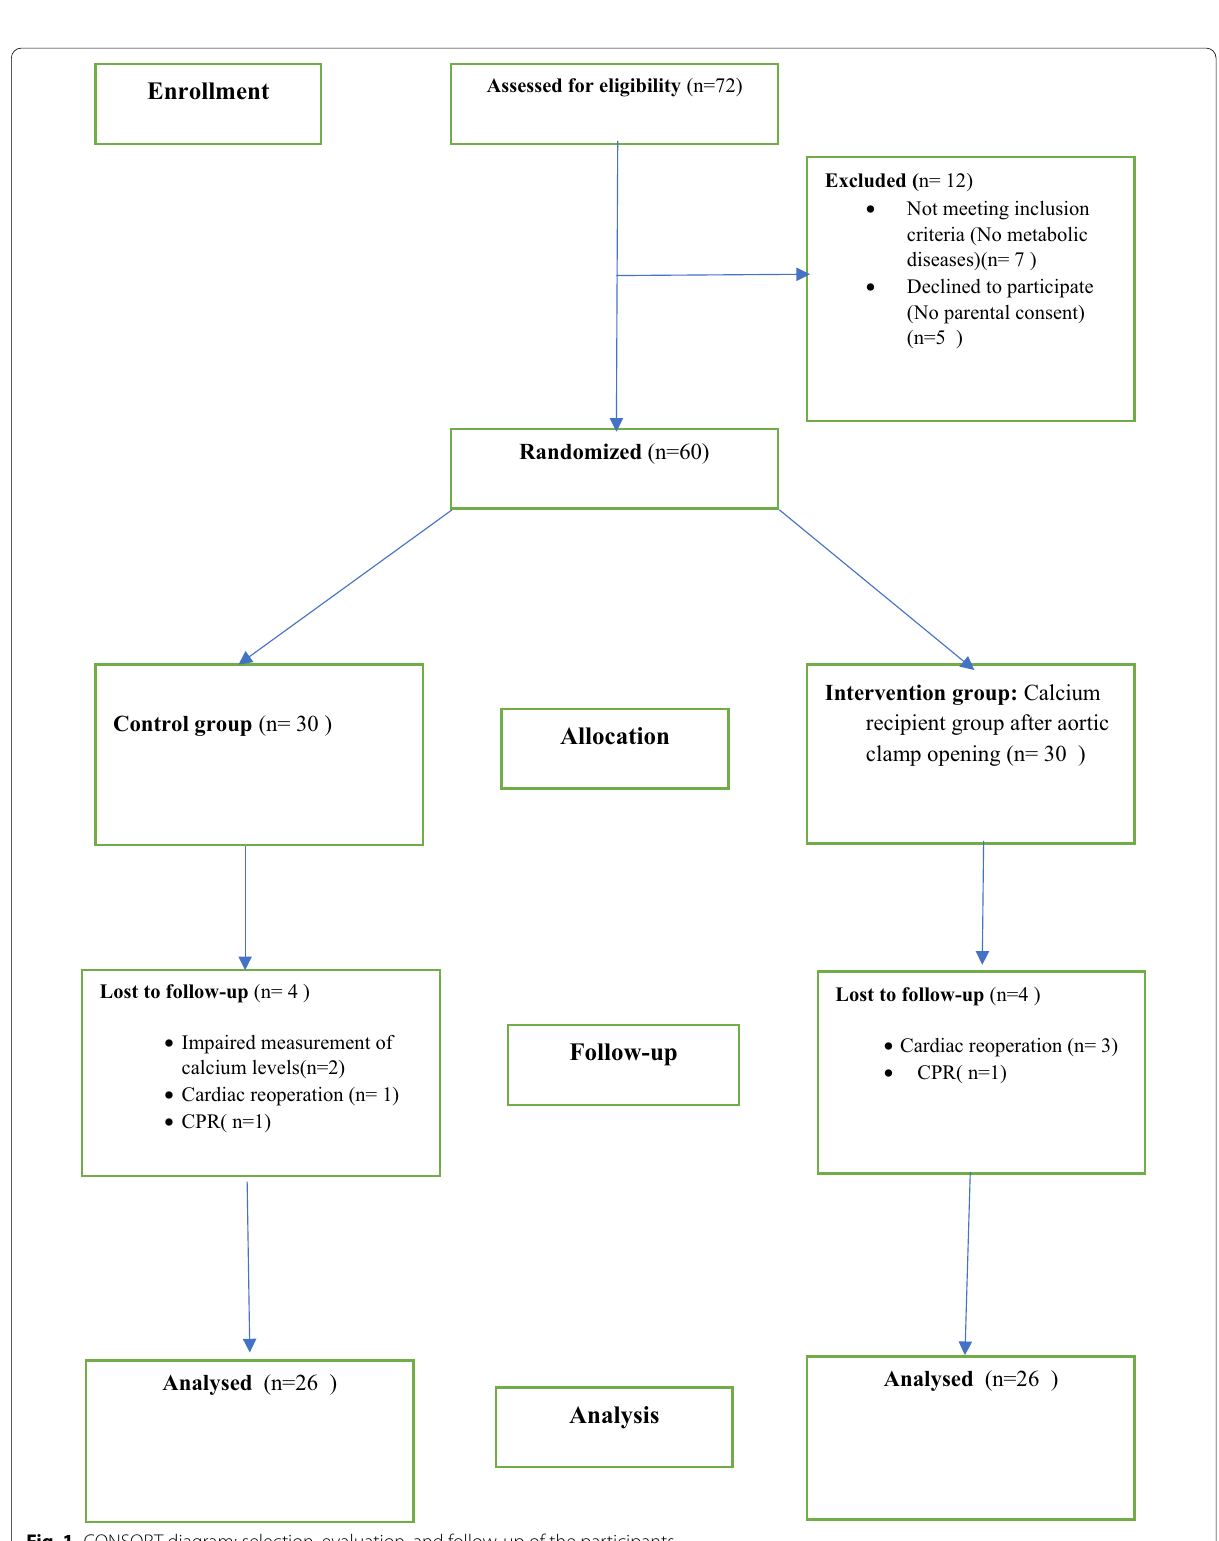
Fig. 1 CONSORT diagram: selection, evaluation, and follow-up of the